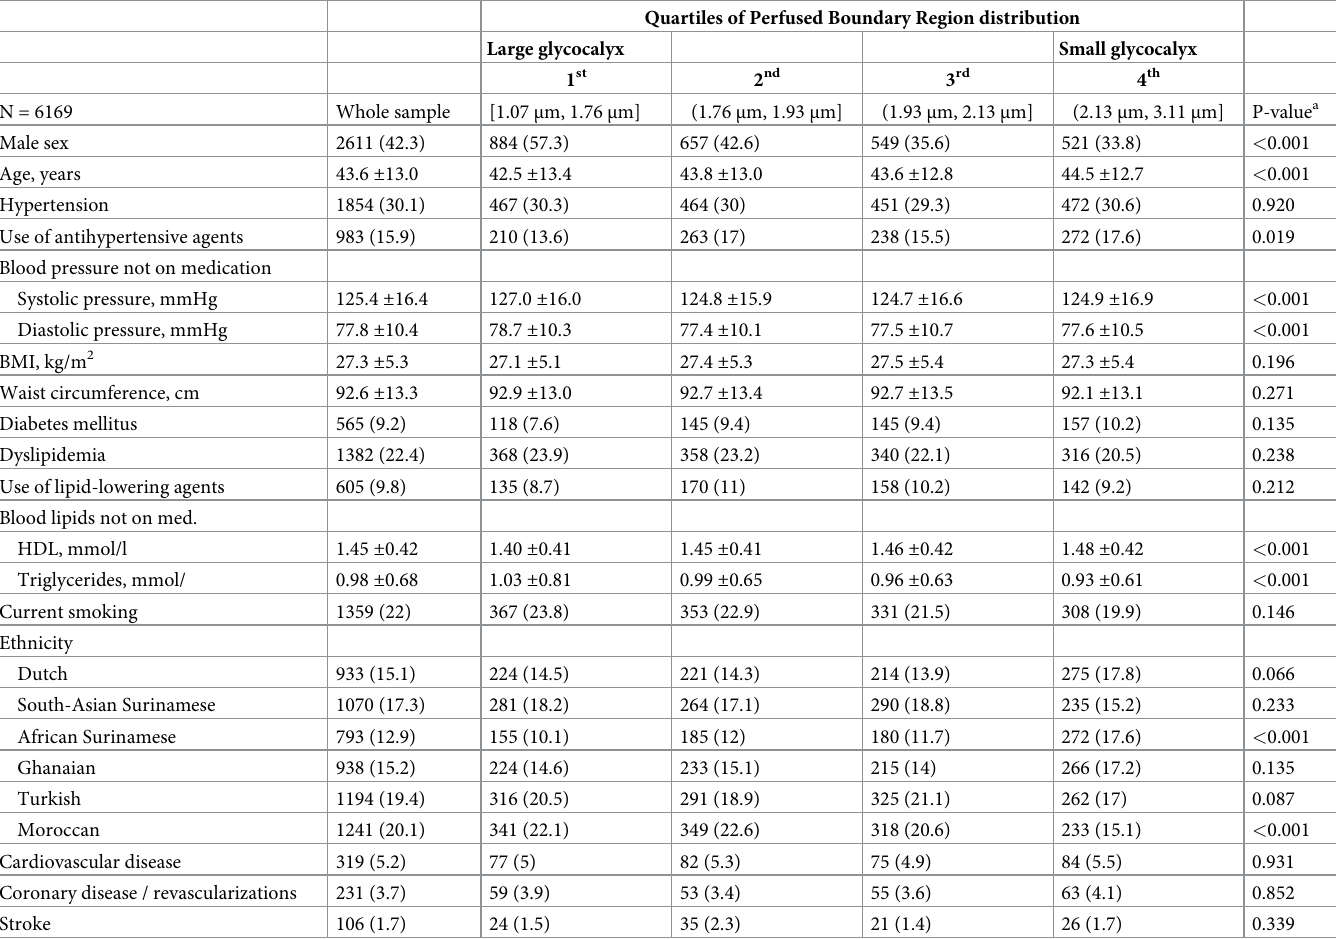
Table 1. Sample characteristics by quartiles of Perfused Boundary Region (glycocalyx size). Quartiles of Perfused Boundary Region distribution Large glycocalyx Small